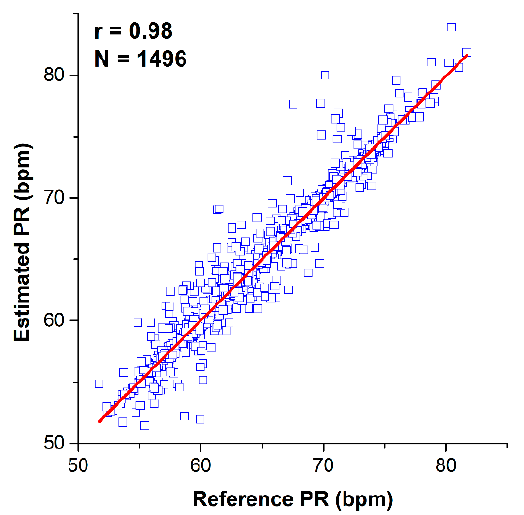
Figure 9. Correlation plot of estimated pulse rate (PR) from the proposed structure against the commercial device at various locations.